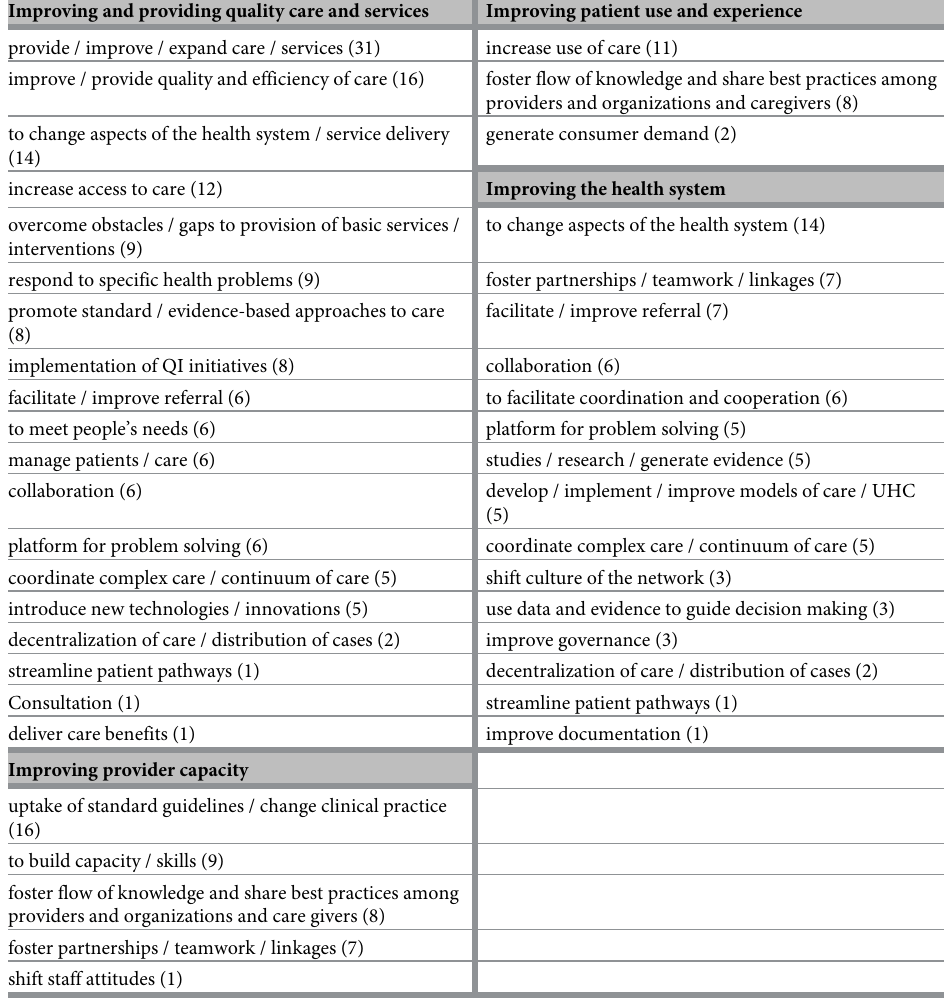
Table 4. Reported network uses by category with corresponding number of references from the selected literature. Improving and providing quality care and